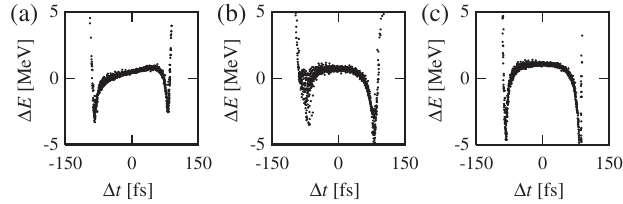
FIG. 8. Longitudinal phase space at the exit of the beam spreader for on-crest acceleration of the compressed bunch. (a) No dechirping arcs. (b) Four isochronous dechirping arcs (containing a total of 12 bending magnets) at beam energy of 400 MeV. (c) Four isochronous dechirping arcs at beam energy of 1.7 GeV.